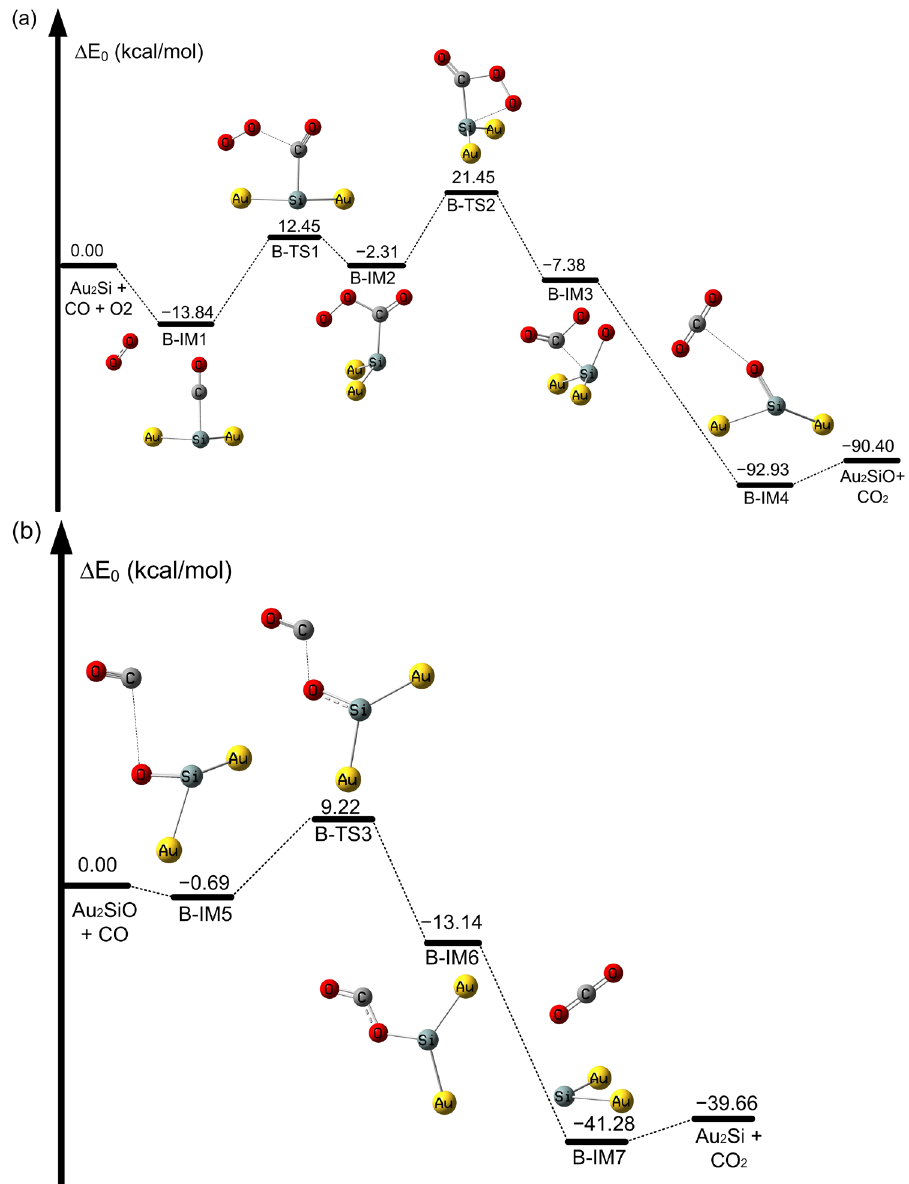
Figure 3. Potential energy profile of CO oxidation on SiAu 2 atoms at the CAM-B3LYP/aug-cc-pVDZ- PP level. ( a ) Oxidation of CO on the SiAu 2 cluster and ( b ) oxidation of CO on the OSiAu 2 cluster (in